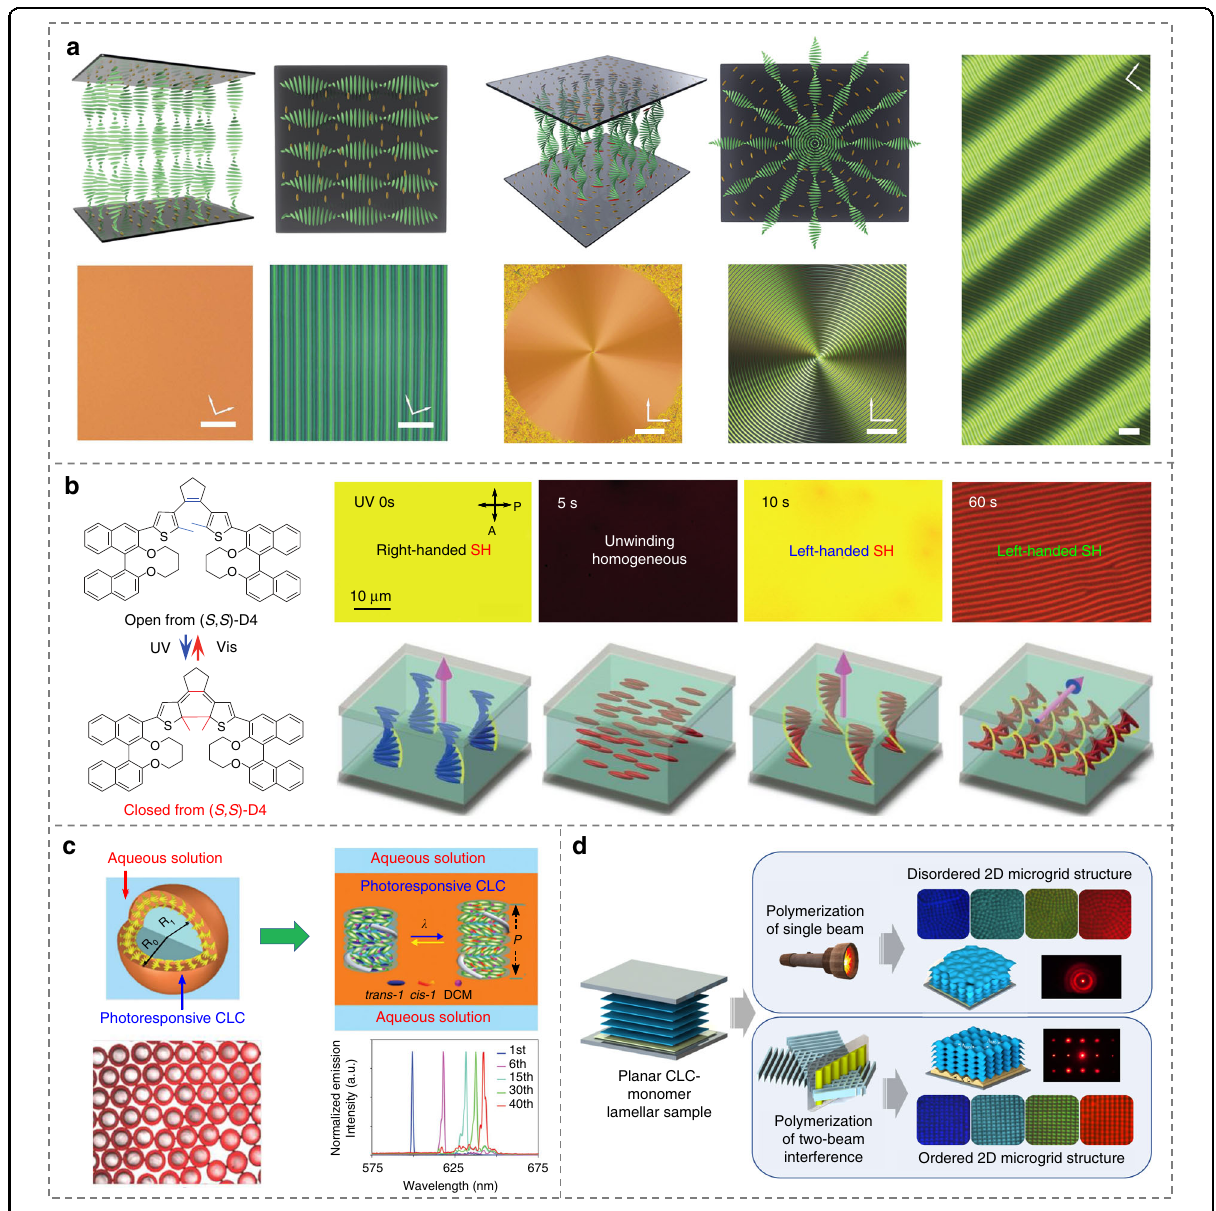
Fig. 6 Creations and modulations of helical architectures in CLCs. a Photopatterned CLC helical superstructures 121 . Reproduced from ref. 121 , with permission from Wiley-VCH. b 3D manipulation of the helical axis of CLCs by light 122 . Reproduced from ref. 122 , with permission from Springer Nature: Nature. c Light-driven CLC microshells 124 . Reproduced from ref. 124 , with permission from Wiley-VCH. d Photopolymerization-induced 2D helical deformations 125 . Adapted with permission from ref. 125 . Copyright 2021 American Chemical